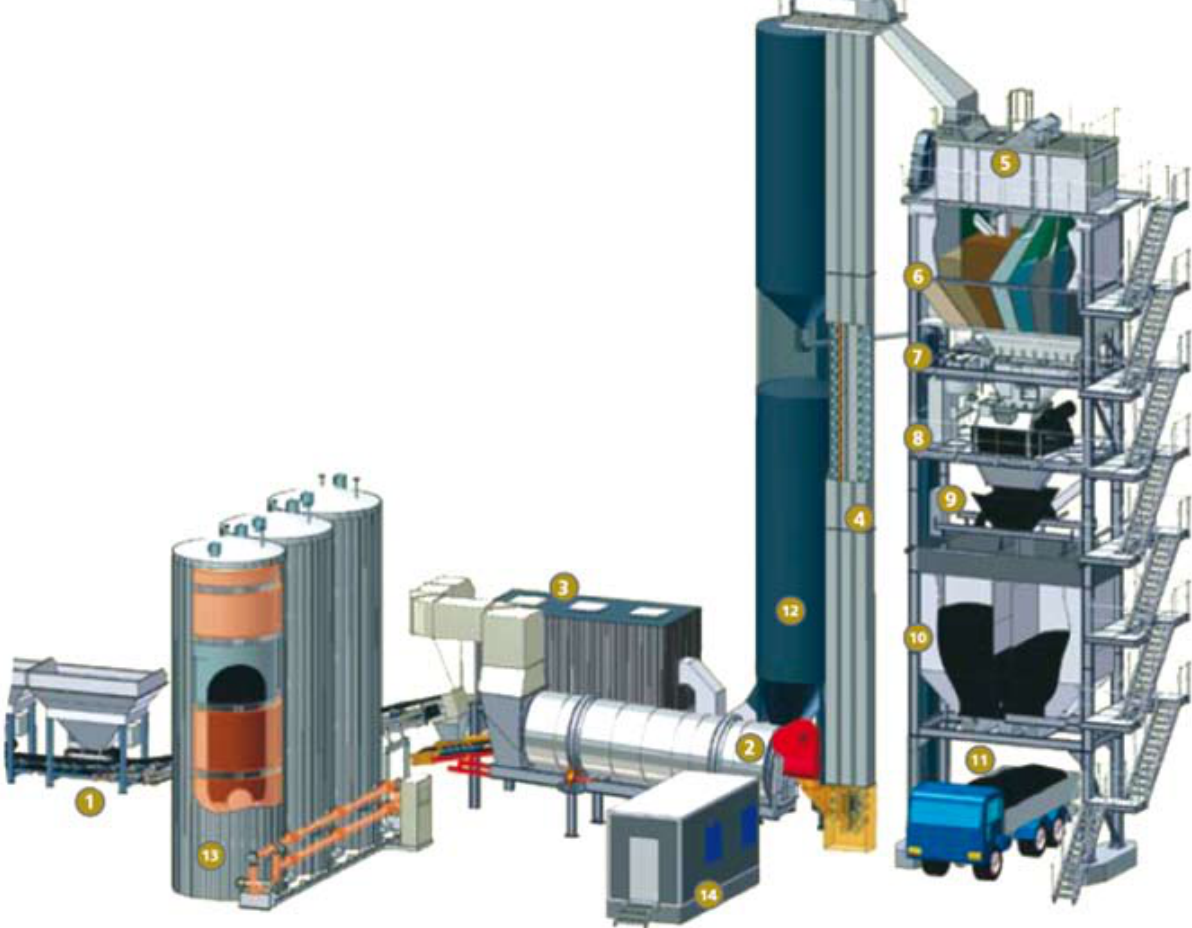
Fig. 1 . Construction of batch-type asphalt mixing plant (AMP): 1 – cold feed with integrated collector belt; 2 – drying drum with burner; 3 – filter-type dust collector with centrifugal force coarse dust separator; 4 – chain elevator; 5 – hot screen with bypass changeover flap; 6 – hot aggregate silo with 6 mineral compartments plus a bypass; 7 – weighing platform with scales for mineral materials, imported fillers, reclaimed dust, bitumen and special materials; 8 – mixing platform twin-shaft paddle mixer; 9 – movable hopper, optional horizontal skip; 10 – hot mix silo; 11 – truck loading; 12 – silo tower for reclaimed dust and imported filler; 13 – electrically heated bitumen tank installation; 14 – command container with control system (Available from